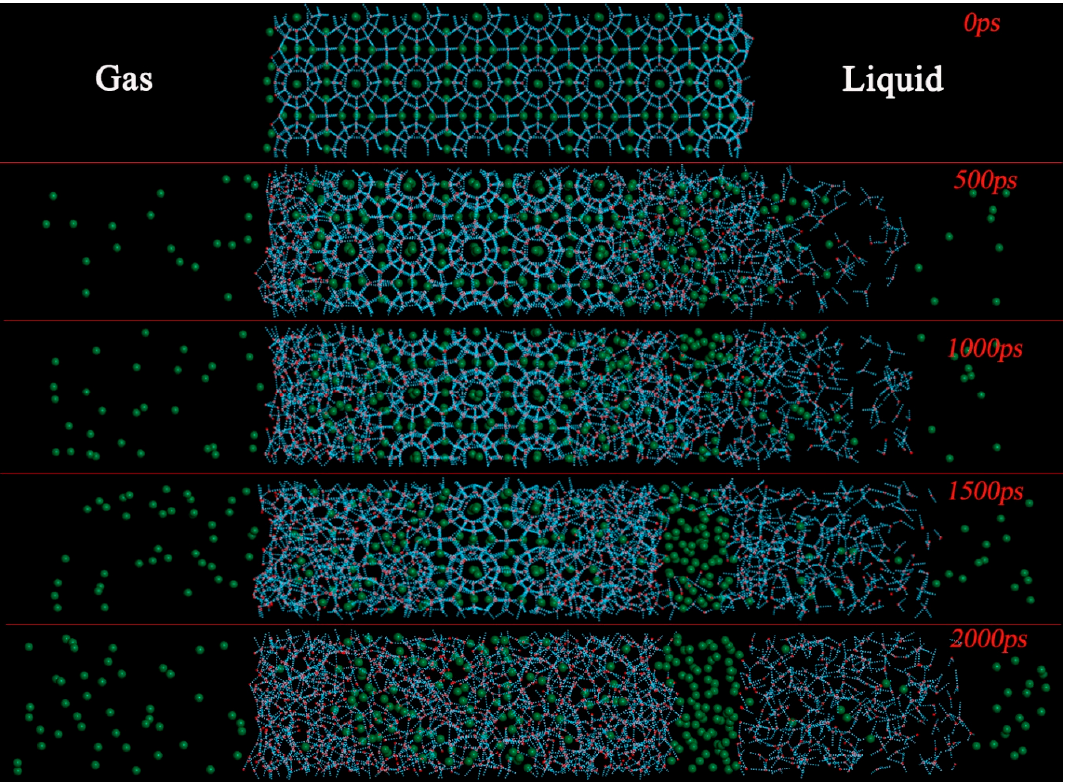
Figure 3. A layer by layer breakdown of closed cages in hydrate slab from the two interfaces to center. To facilitate the observation of hydrate dissociation process, all molecules in liquid and gas phases and H 2 O molecules in hydrate slab are hidden. CH 4 molecules in hydrate slab is displayed as green ball, and the blue dotted lines in hydrate slab are hydrogen bond.